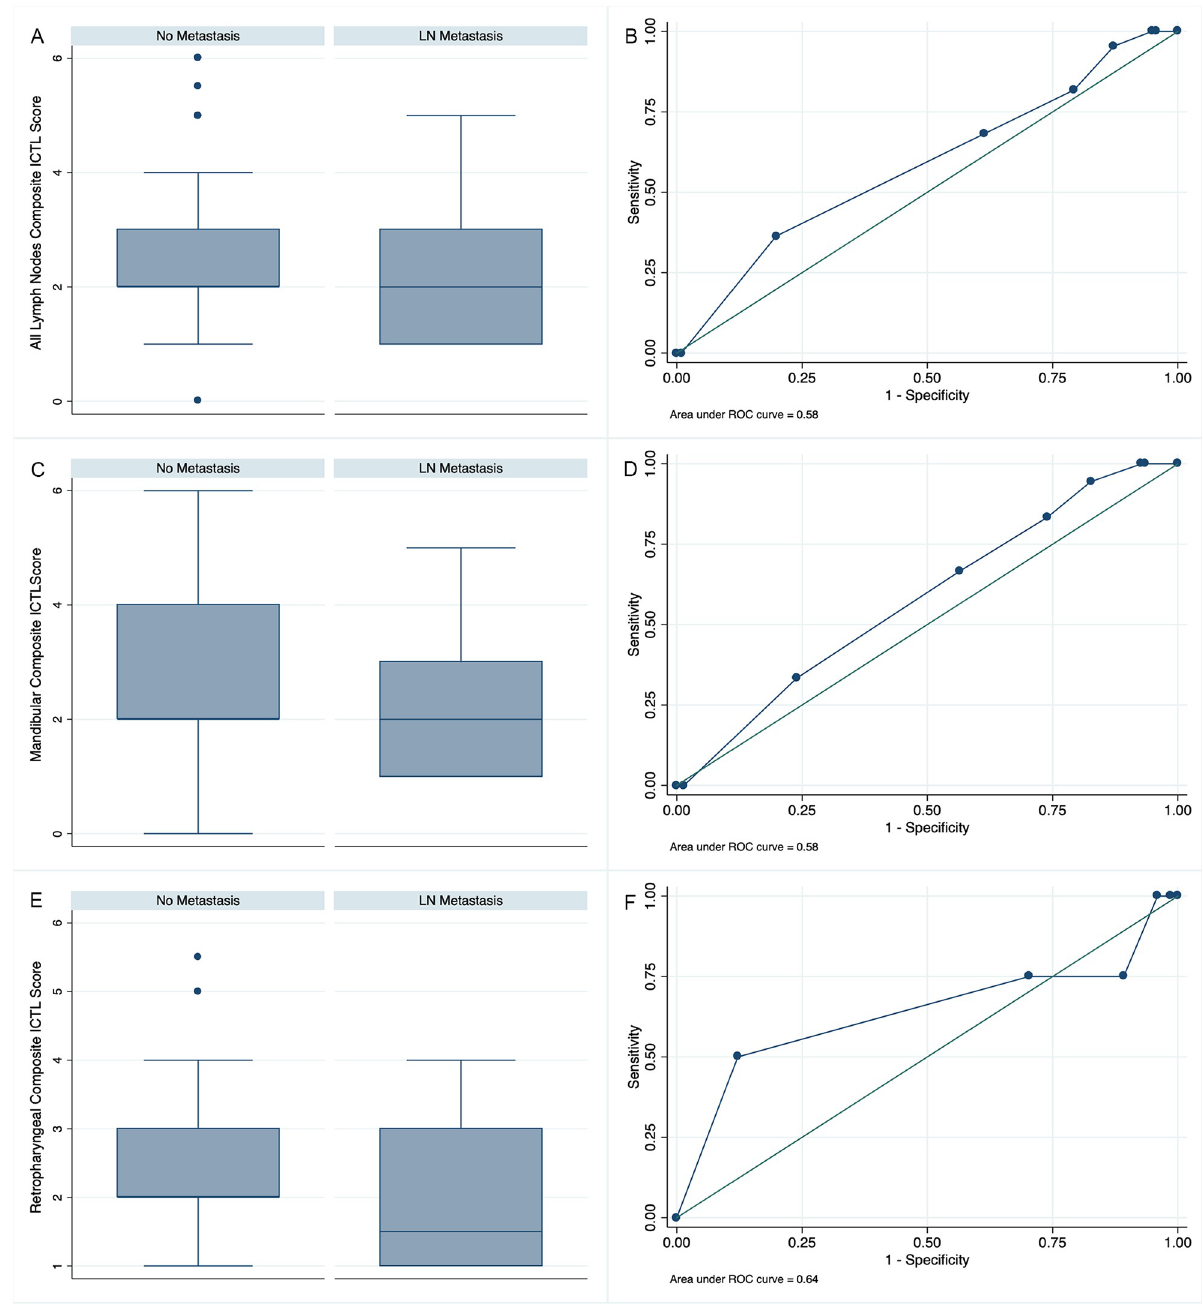
Fig 6. Differences identified between composite indirect computed tomography lymphangiography (ICTL) scores between metastatic and non- metastatic cervical lymph nodes (LNs) in dogs with oral tumors. Box and whisker plots demonstrating the median (center line) with the end of the boxes indicating the 25 th and 75 th percentiles and the whiskers indicating the adjacent values of differences in the composite ICTL score in non- metastatic LNs and metastatic LNs for all LNs combined (A) mandibular LNs (MLNs) alone (C), and medial retropharyngeal LNs (MRLNs) alone (E). The associated receiver operating characteristic curves demonstrate the predictive ability of the logistic regression model of the composite score for the detection of histopathologic metastasis for all LNs (B), MLNs alone (D), and the MRLNs alone (E).